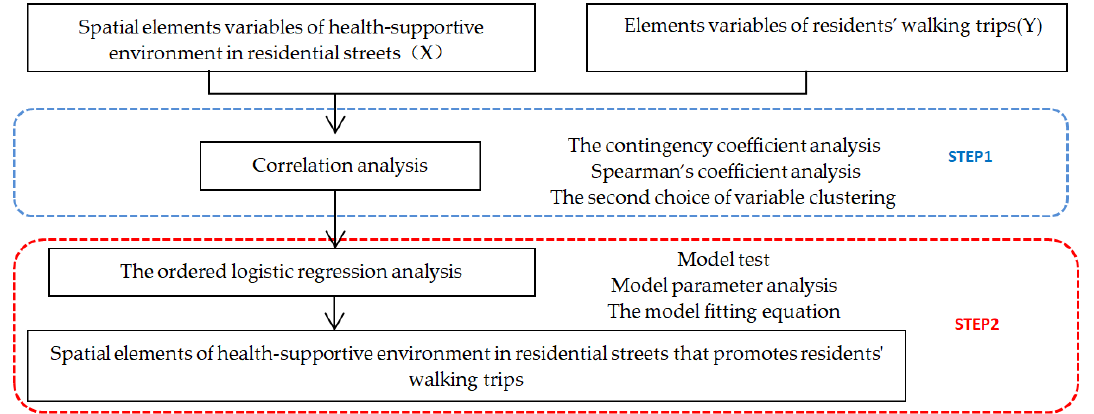
Figure 6. Steps of the quantitative analysis.